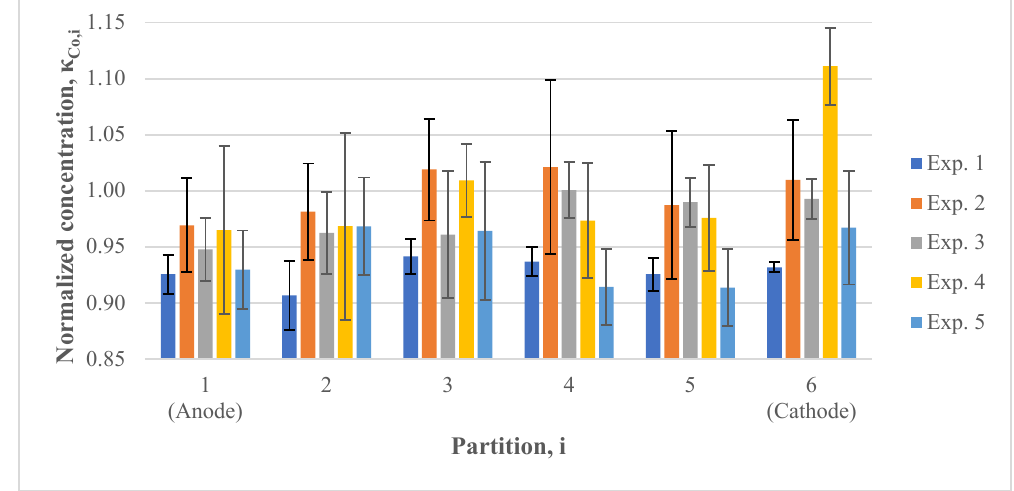
Figure 2. Total cobalt concentration profiles.